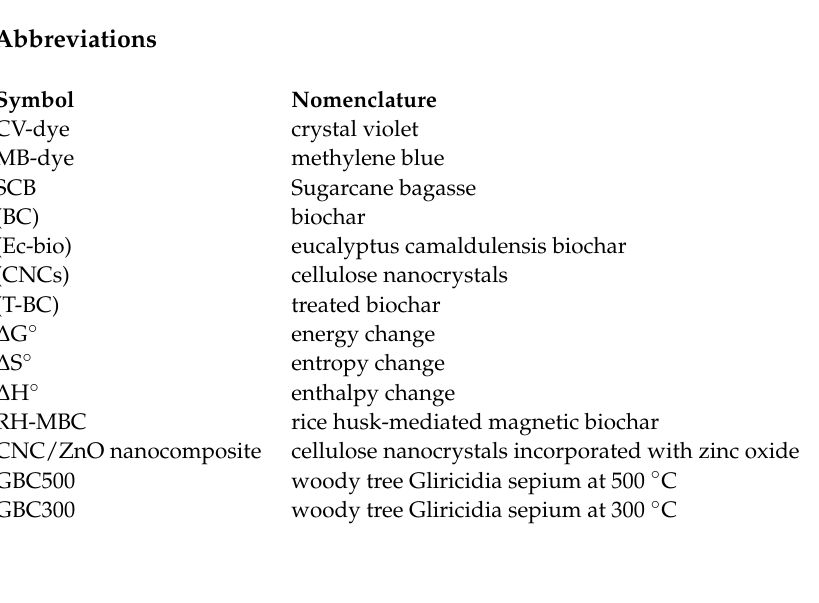
Figure S3. Effect of NaOH concentration on the adsorption efficiency of treated biochar; Table S1. Surface area, pore volume, and pore diameter of SCB, BC and T-BC. section S1.1. Materials